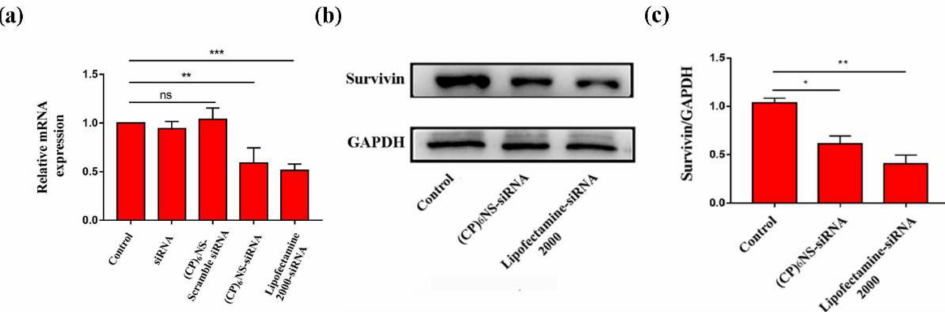
Figure 7. Effect on survivin by (CP) 6 NS delivering survivin siRNA. ( a ) The expression of survivin mRNA was analyzed by qRT-PCR. ( b ) The expression of survivin protein was analyzed by Western blots. ( c ) Statistics on the expression of survivin protein with GAPDH as the internal reference. Each value is expressed as the mean ± SD ( n =